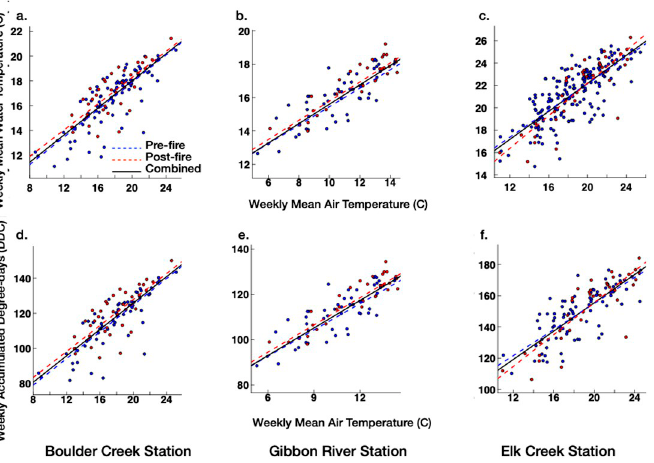
Fig 5. Pre- and post-fire regression lines for weekly summer mean air temperature(MAT)—mean water temperature (MWT) and accumulated degree days (ADD) data for (a and d) Boulder Creek, (b and e) Gibbon River, and (c and f) Elk Creek stream sites. Red and blue filled circles represent the pre- and post-fire weekly summer MAT–MWT or ADD events, respectively. https://doi.org/10.1371/journal.pone.0268452.g005 in the winter MWT by 0.16˚C ( S . E . = 0.45˚C) and winter ADD by 43.5 DDC ( S . E . = 40 DDC) for the three post-fire years for the studied downstream site (Fig 6a–6d). Wildfires were related to a median increase in the summer MWTs by 0.39˚C ( S . E . = 0.17˚C) for the Boulder Creek site and 0.56˚C ( S . E . = 0.13˚C) for the Gibbon River site for the three post-fire years (Fig 7a and 7b). These fires were also associated with elevating summer ADDs by 47.6 DDC ( S . E . = 15.3 DDC) for the Boulder Creek site and 62 DDC ( S . E . = 11.7 DDC) for the Gibbon River site (Fig 7d and 7e). On the other hand, wildfire burns at Elk Creek watershed corresponded to a median decrease in the summer MWT by 0.08˚C ( S . E . = 0.23˚C) and a median decrease in the summer ADD by 16.3 DDC ( S . E . = 20.7 DDC) for the three post-fire years for the studied downstream site (Fig 7c and 7f).